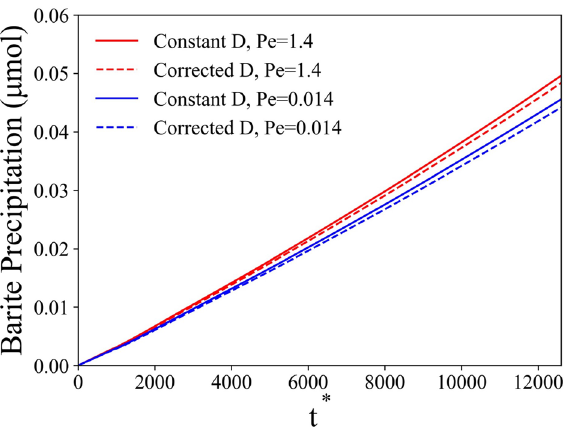
Figure 14. Precipitated solid phase mass as a function of nondimensional time with/without activity correction.